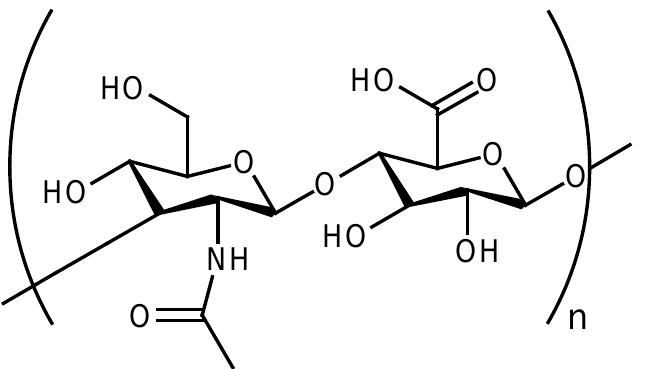
Figure 7. Chemical structure of hyaluronic acid.